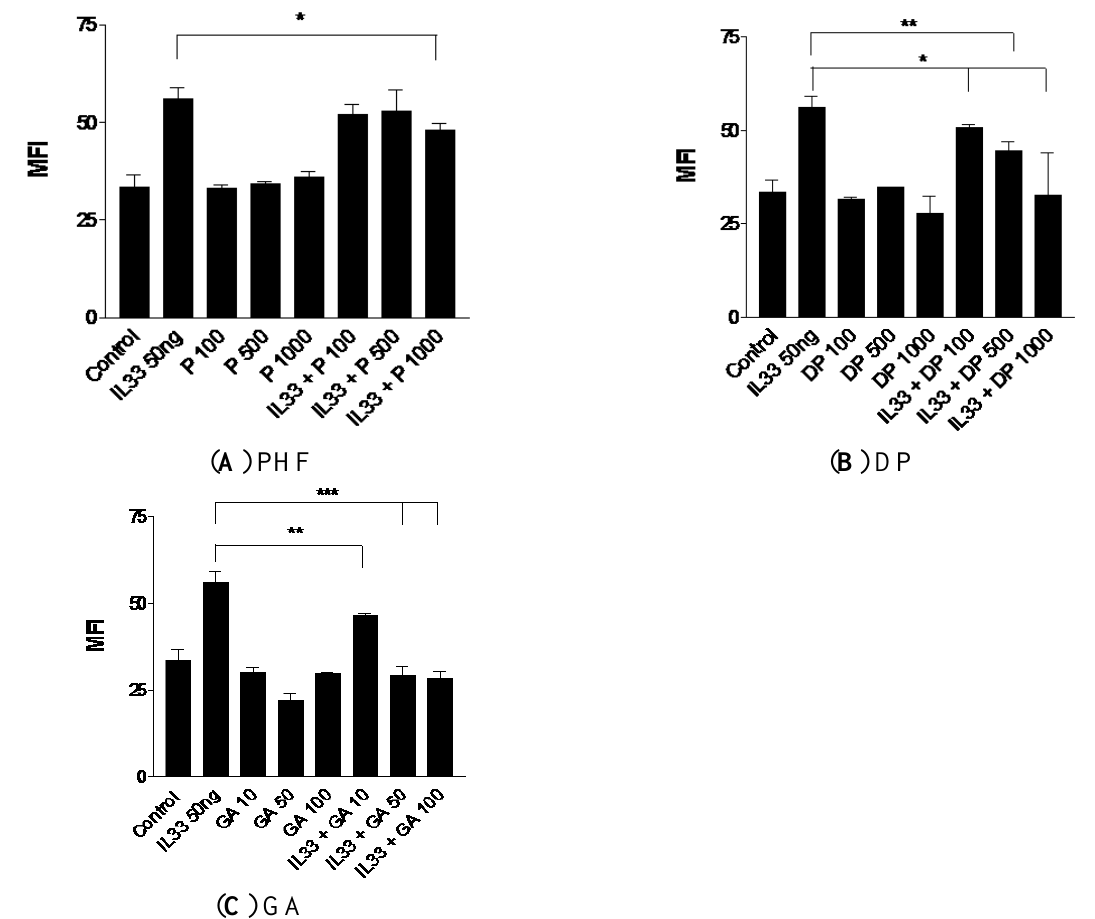
Figure 1. Suppressive effect of ICAM-1 expression on IL-33-activated human basophilic KU812 cells treated with ( A ) PHF (100, 500 and 1,000 μg/mL), ( B ) DP (100, 500 and 1,000 μg/mL), ( C ) GA (10, 50 and 100 μg/mL) for 18 h. As shown in bar charts, surface expressions of ICAM-1 on 5,000 KU812 cells are expressed as the mean plus SEM of MFI and normalized by subtracting appropriate isotypic control of three independent experiments. * p < 0.05, ** p < 0.01, *** p < 0.005. P100-1000: PHF 100–1,000